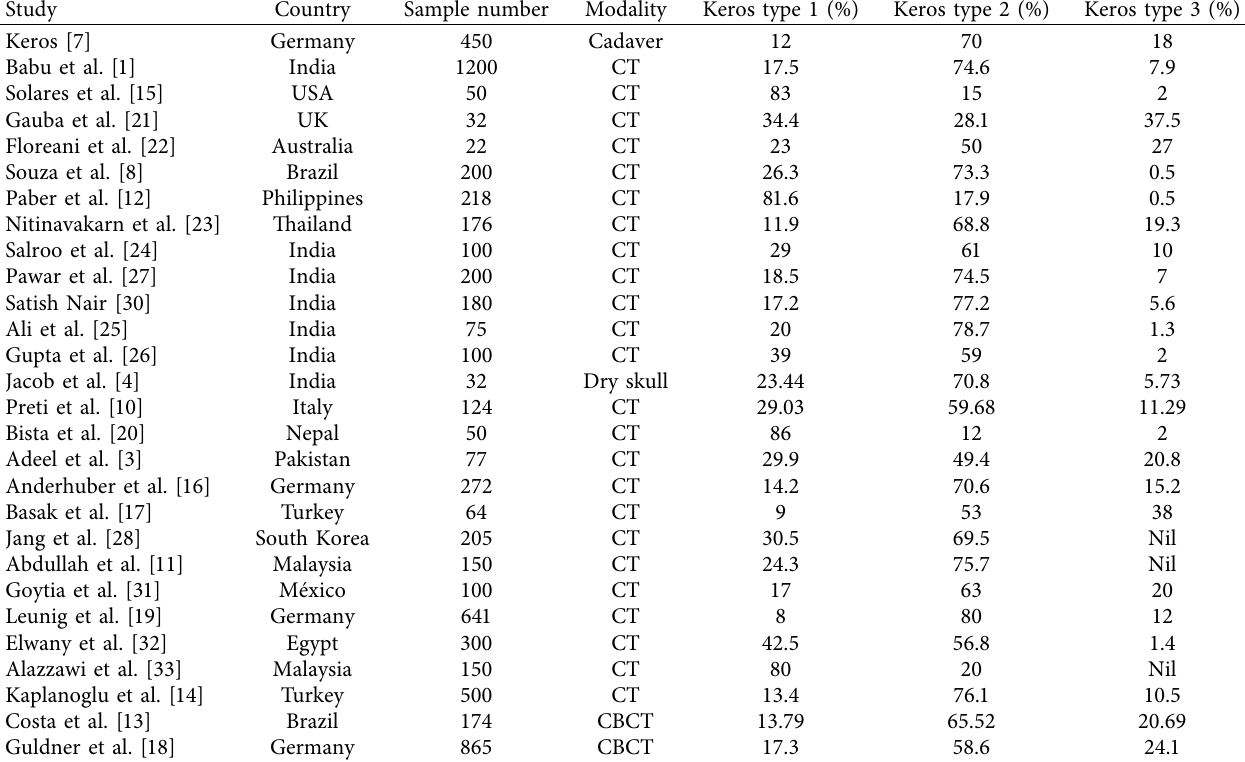
Table 7: The incidence of Keros types in different populations.